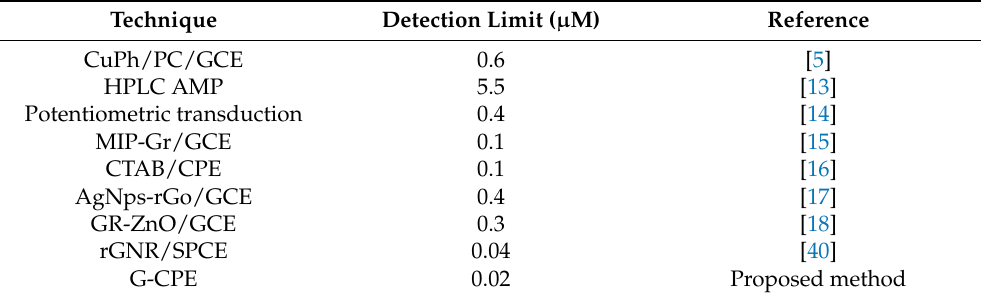
Table 1. Comparative study of the limit of detection with some published reports.